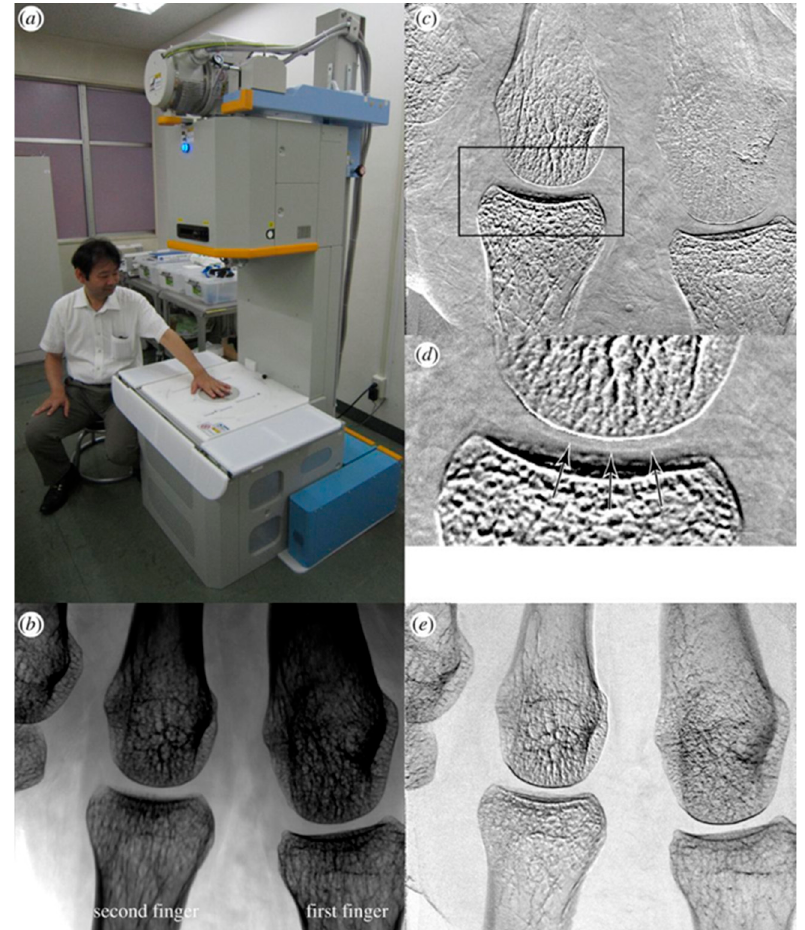
Figure 11. ( a ) X-ray Talbot–Lau phase-imaging system installed in a hospital and resultant ( b ) absorption image and ( c ) differential phase image. ( d ) Zoomed image of the rectangle shown in ( c ). ( e ) Visibility image of a part of the palm of the first author in this study. X-ray refraction in the vertical direction of the images is sensed. The cartilage in a joint is revealed as indicated by the arrows in ( d ). The blurry feature at the upper right of ( c ) is considered due to movement during the measurement (online version in color). This figure is reproduced with permission from [91] published by A. Momose in Mathematical, Physical and Engineering Science in 2014, Figure 2).